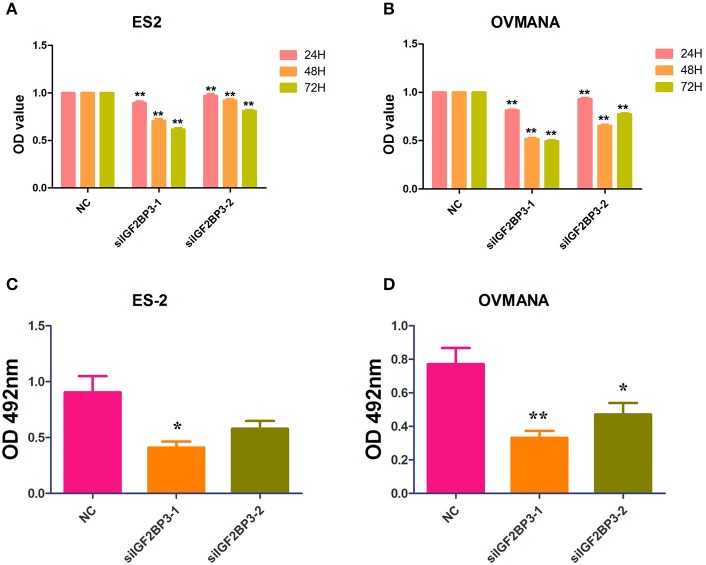
Growth inhibition of ES2 and OVMANA cell lines by siIGF2BP3 revealed by CCK8 and crystal violet assay. (A) Cell proliferation index determined after NC, siIGF2BP3-1, siIGF2BP3-2 for 24, 48, or 72 h in ES2 cells. (B) Cell proliferation index determined after NC, siIGF2BP3-1, siIGF2BP3-2 for 24, 48, or 72 h in OVMANA cells. OD450 value has been normalized to 1 in each negative control group. (C) OD570 value after different treatments in ES2 cells. (D) OD570 value after different treatments in OVMANA cells. **P < 0.01.